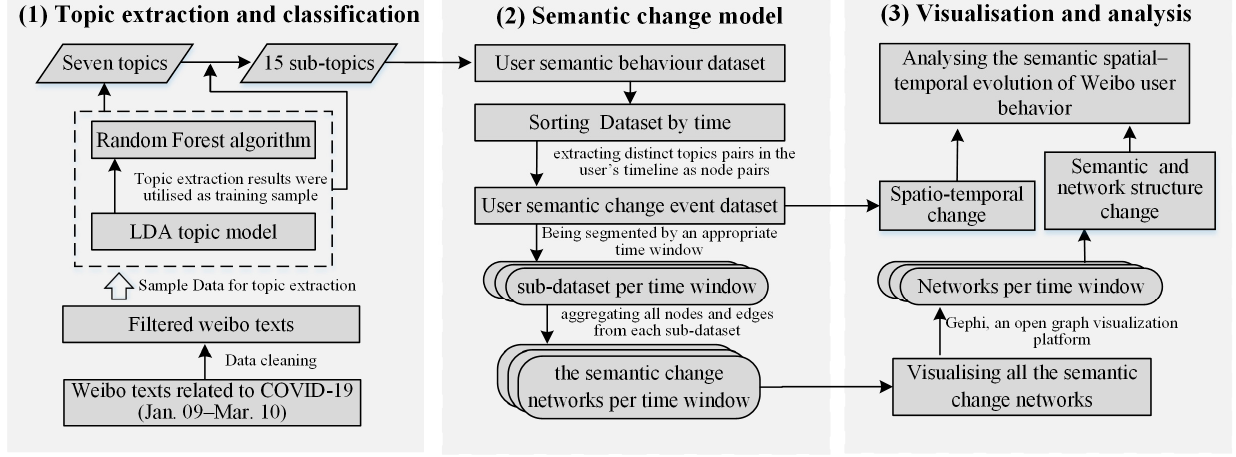
Figure 1. The framework for extracting the thematic evolution and temporal–spatial pattern of public behavior during disaster events.